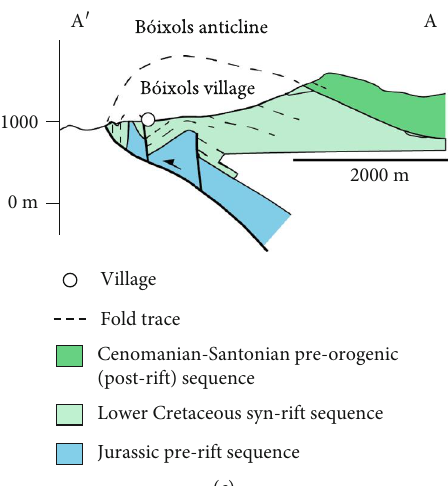
Figure 1: (a) Simpli fi ed geological map of the Pyrenees (modi fi ed from [32]). (b) Geological map of the Sant Corneli-Bóixols anticline showing the studied outcrop (modi fi ed from [38, 39]). (c) N-S cross section of the Sant Corneli-Bóixols anticline (modi fi ed from [40]). Location is shown in